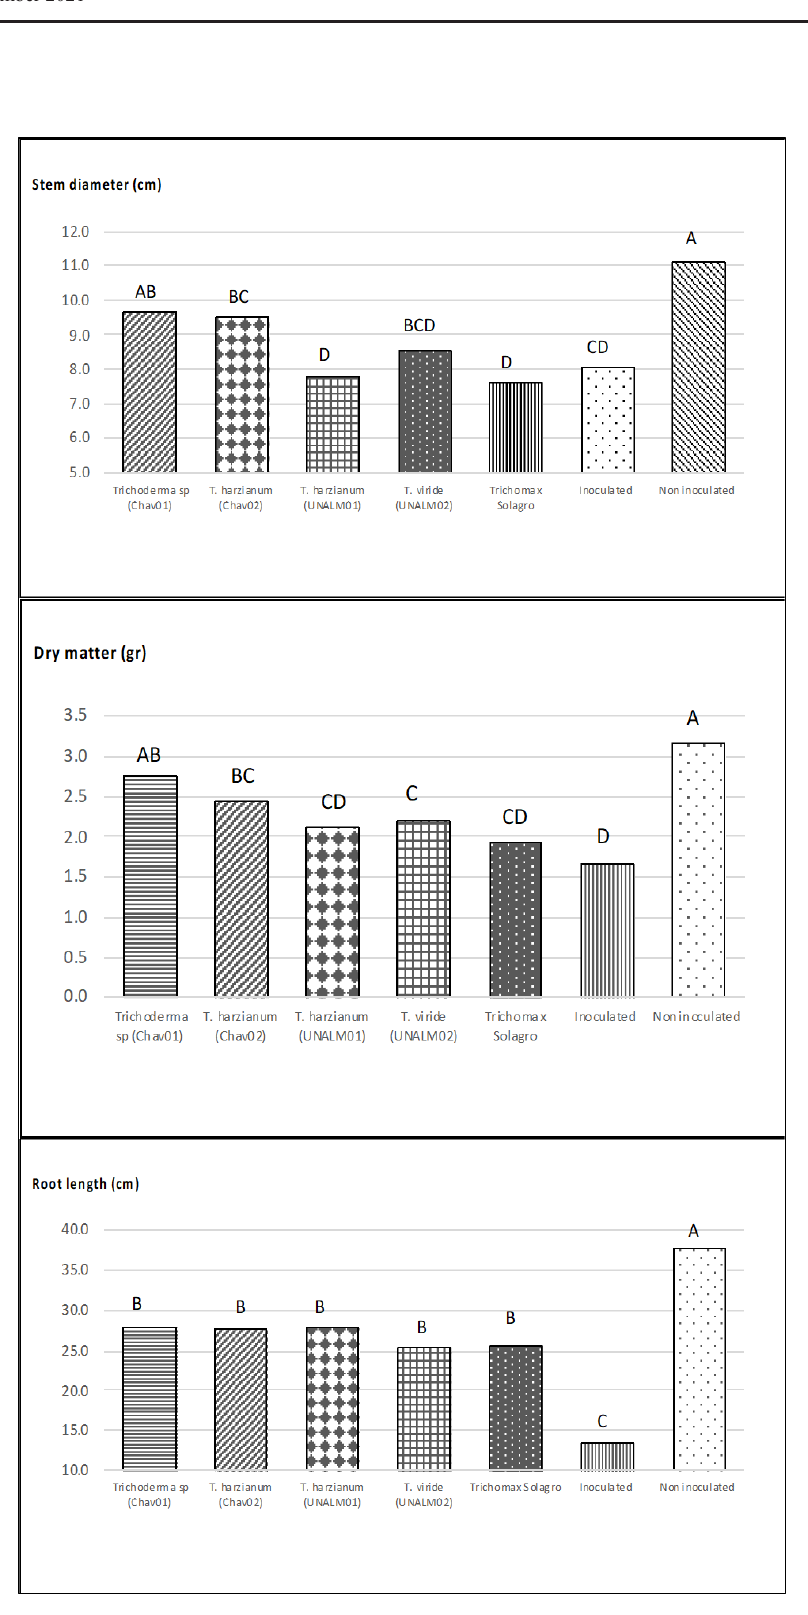
Fig. 2. Stem diameter (cm), root dry weight (g), and root length (cm) of avocado seedlings inoculated with Phytophthora cinnamomi and treated with different Trichoderma isolates for 60